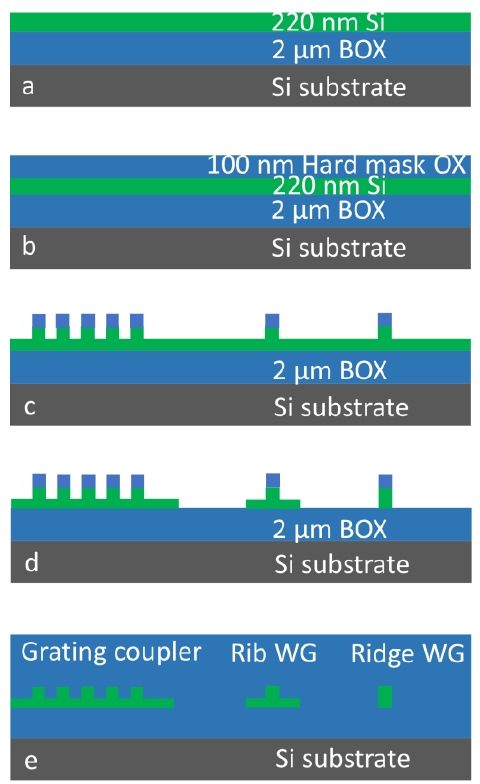
Figure 6. Passive device manufacturing. Schematic representation of the main process steps: ( a ) SOI wafer as starting material, ( b ) silicon dioxide hard mask deposition, ( c ) silicon structuring by time- controlled shallow etching, ( d ) complete silicon etching in selected areas, ( e ) silicon dioxide top cladding deposition with Chemical-mechanical polishing (CMP)